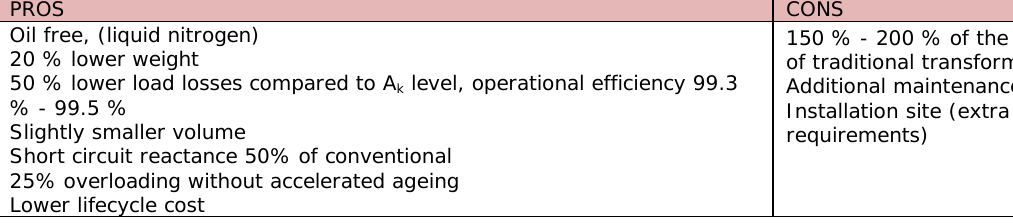
Table 5. “Pros and cons of HTS transformers”. Source: Targosz & Topalis